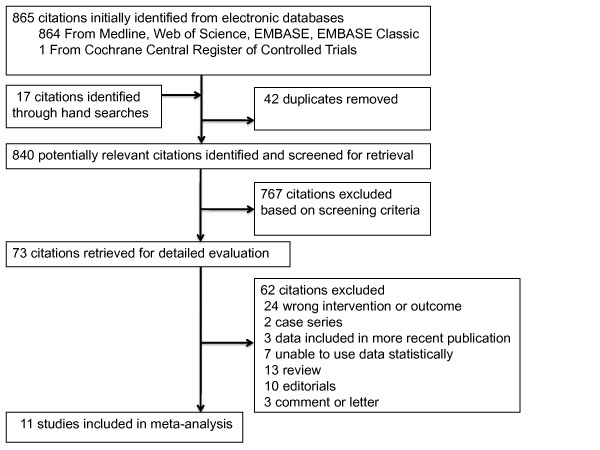
Flowchart of study selection for the systematic review.